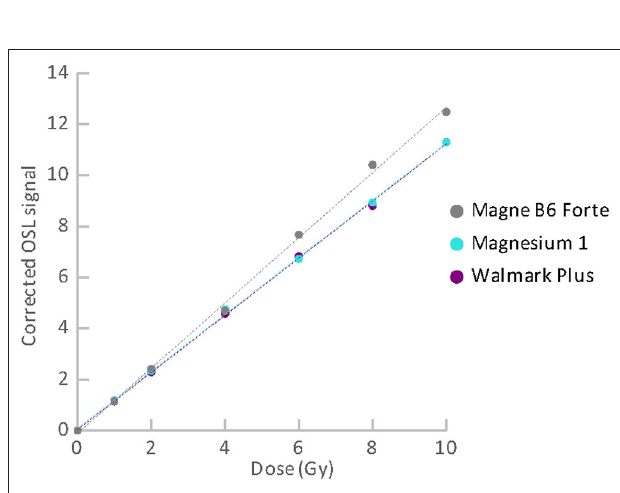
FIGURE 10 | Dose response for the group of food supplements with Mg measured using SAR protocol.